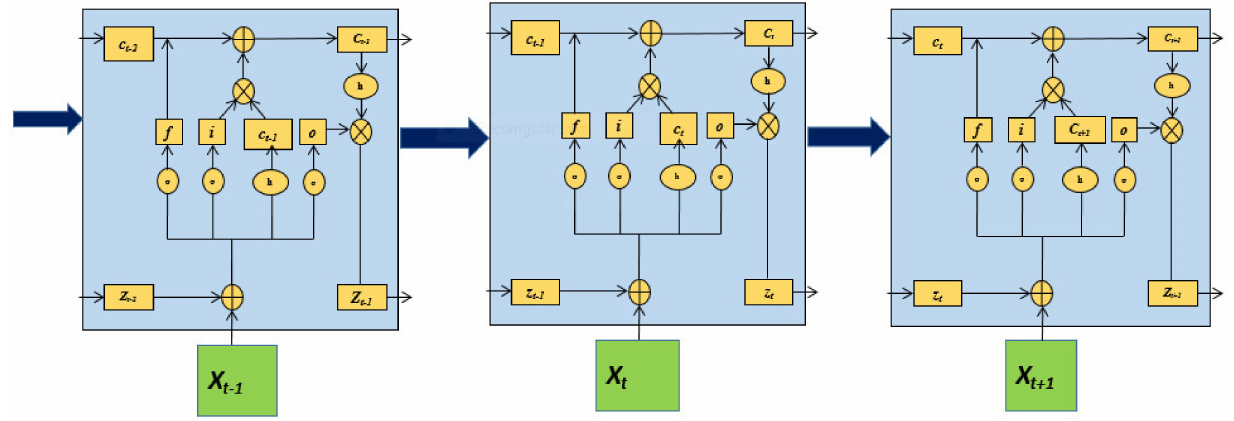
Figure 5. LSTM deep learning model network